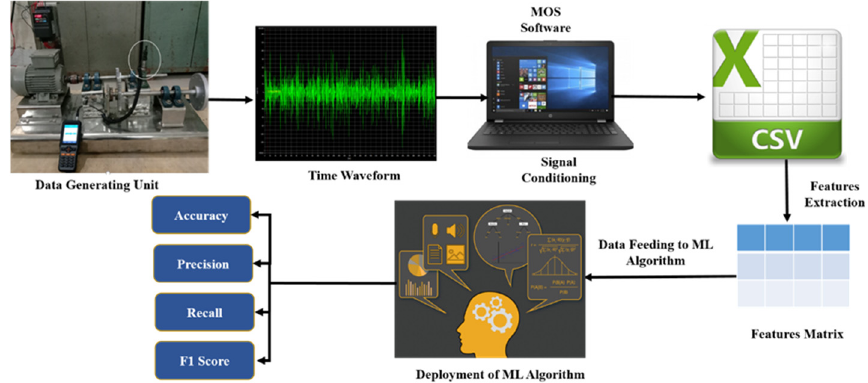
Figure 1. Photograph of the experimental setup.